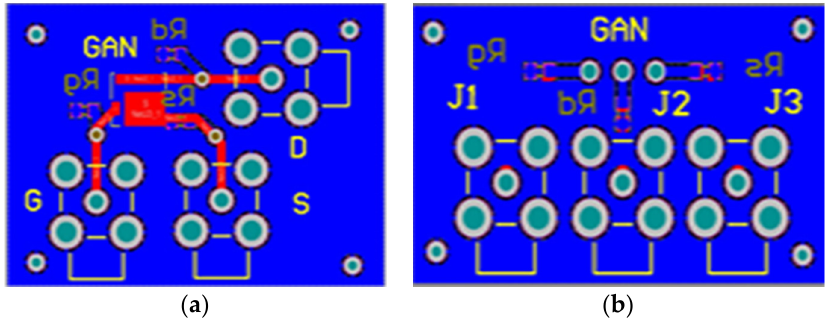
Figure 9. PCB designed for GaN device fixture for: ( a ) SMD packages; and ( b ) TO.